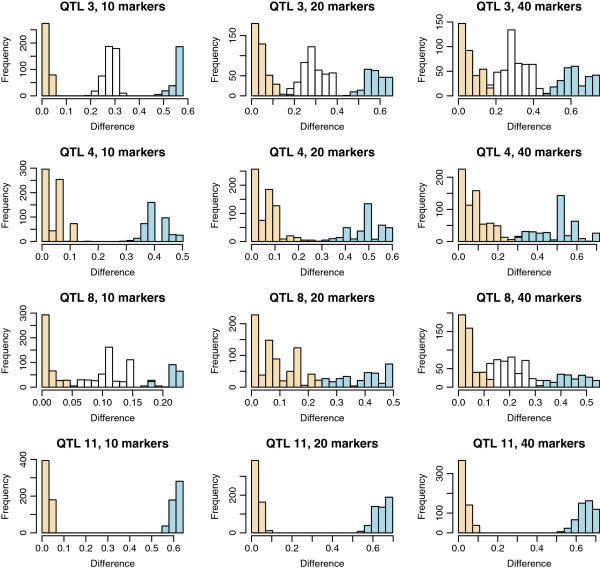
Distribution of the absolute difference between haplotype effects, depending on interval size. Haplotype effects were approximated by the sum of estimated marker effects for all markers in a haplotype.